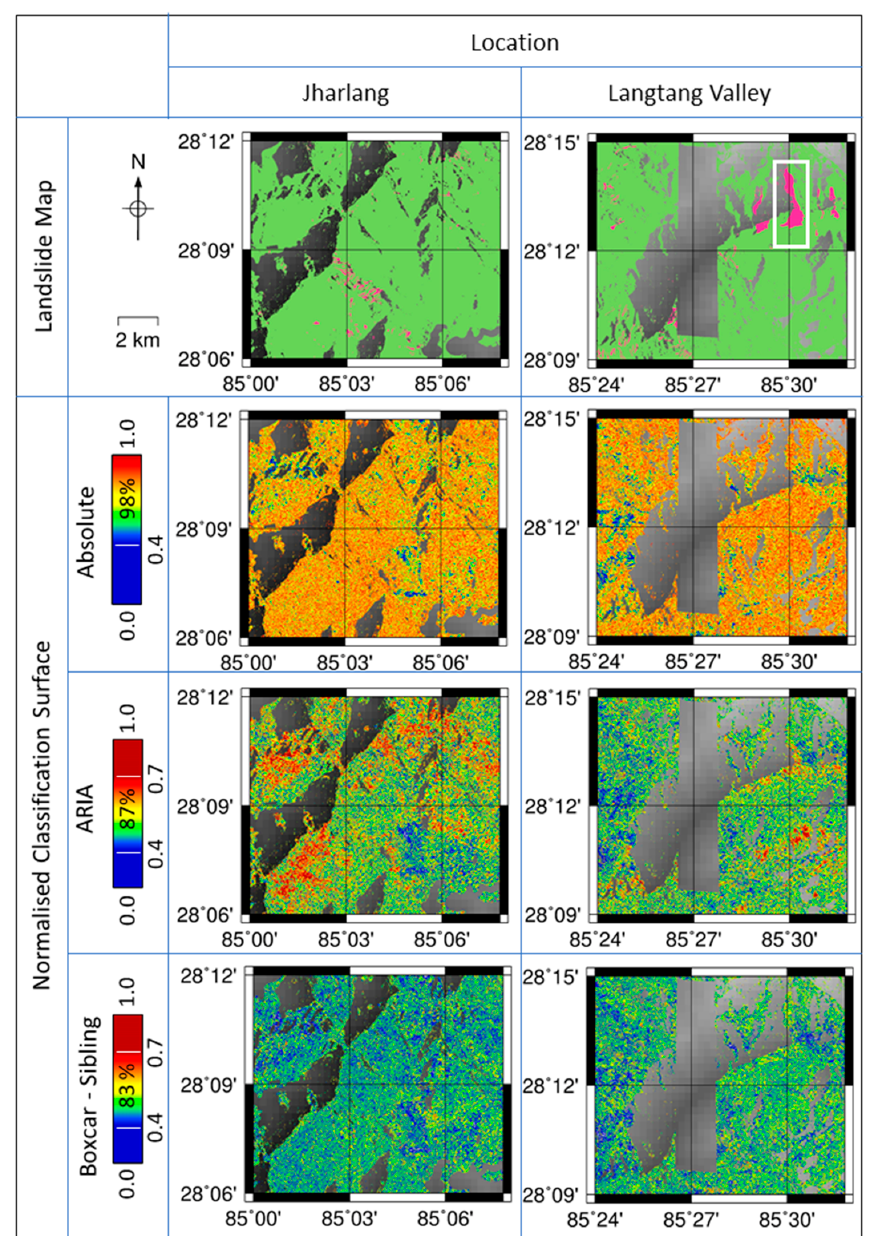
Figure 8. Classification of individual landslides for two example locations. Each column shows mapped landslide polygons (pink) [2] and the normalized classification surface calculated from each method for the Jharlang (left) and Langtang Valley (right) regions. Colour bars are non-linear but linear between the white lines and labelled with the percentage of pixels across the two areas that lie in this linear range. The main body of the Langtang Valley landslide is indicated in white.